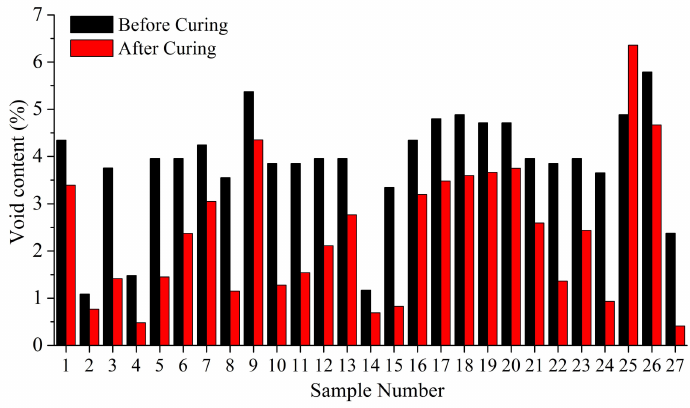
Figure 10. The average void content before and after